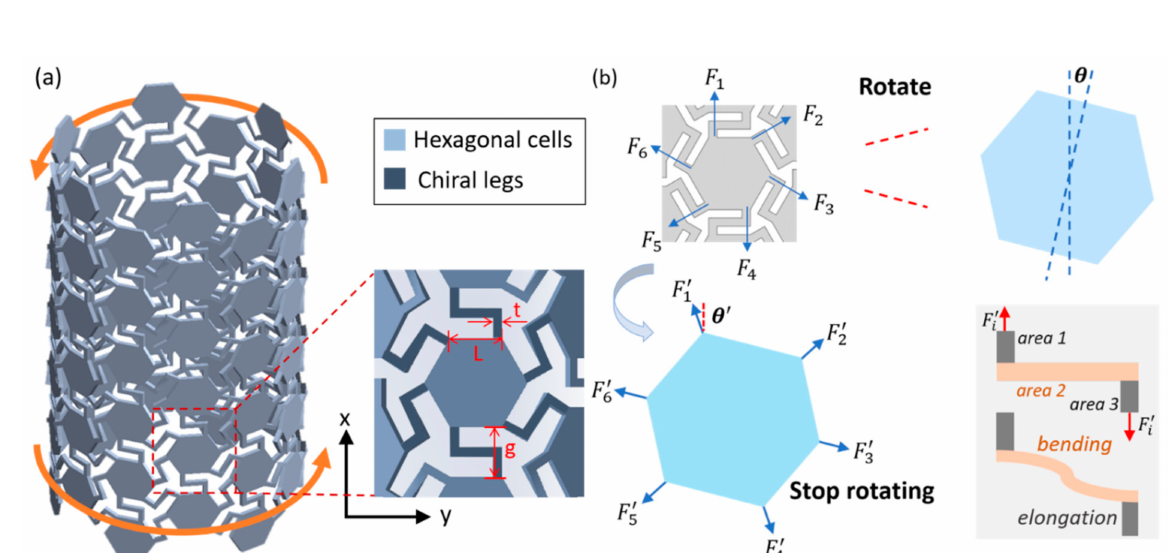
Figure 1. ( a ) Chiral tube assembled by hexagonal units and chiral legs. ( b ) Deformation of hexagonal cells and chiral